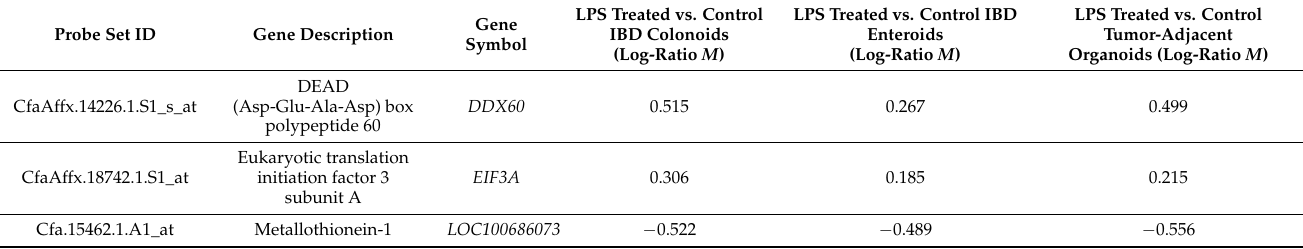
Table 12. A list of genes in the common/same direction between the IBD enteroids, colonoids, and tumor-adjacent organoids following LPS stimulation. The log-ratio M values represent the log(R/G) (log fold change)